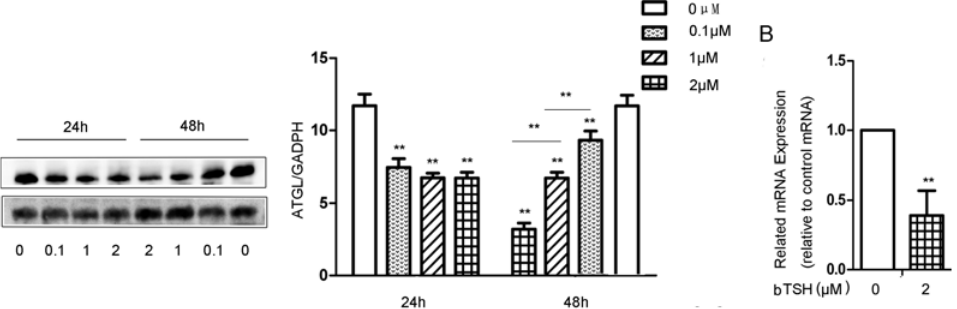
Figure 3. TSH decreased ATGL expression in mature differentiated cells. (A) On D12, the cells were treated with 0.1 μ M bTSH, 1 μ M bTSH or 2 μ M bTSH for 24 h or 48 h in serum-starved DMEM. Proteins were separated by SDS-PAGE and immunoblotted for ATGL and GAPDH. Values are quantified by densitometry and normalized with GAPDH. Representative Western blot results are shown. (B) Total RNA was extracted from differentiated cells treated with 2 μ M bTSH for 48 h in serum-free DMEM. ATGL mRNA levels were determined by real-time PCR and normalized with β -actin. Values are reported as the fold change relative to the control group. The data are from 3 independent experiments and are presented as the mean (cid:2) SD. ** p < 0.01 versus the control group. Original magnification: